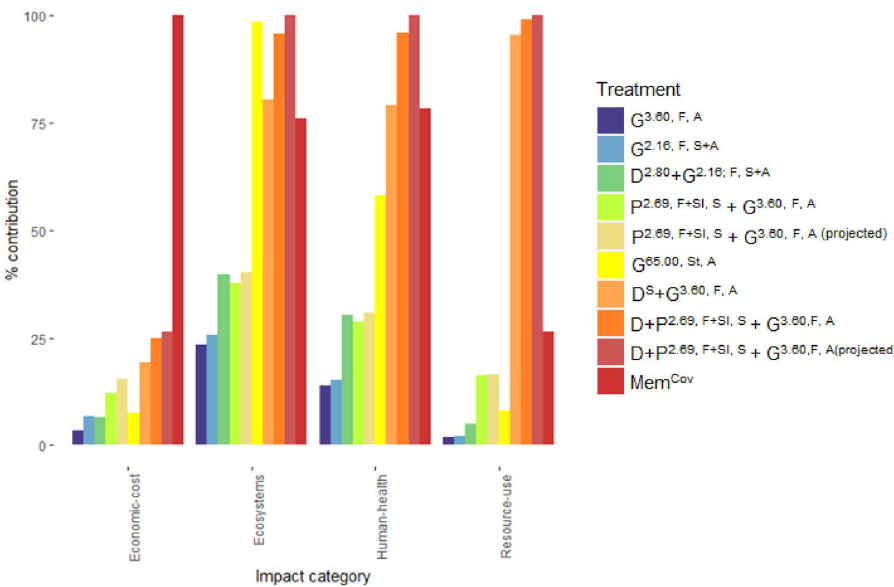
Figure 4. Relative impacts and economic cost of Japanese knotweed treatment methods at endpoint level. See Table 1 for description of